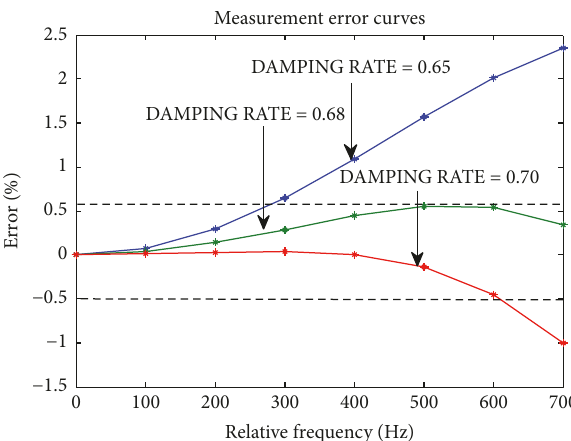
Figure 9: Measurement error as a function of relative frequency for three values of damping rate in the case where the relative frequency is varied from 0 to 1000Hz.